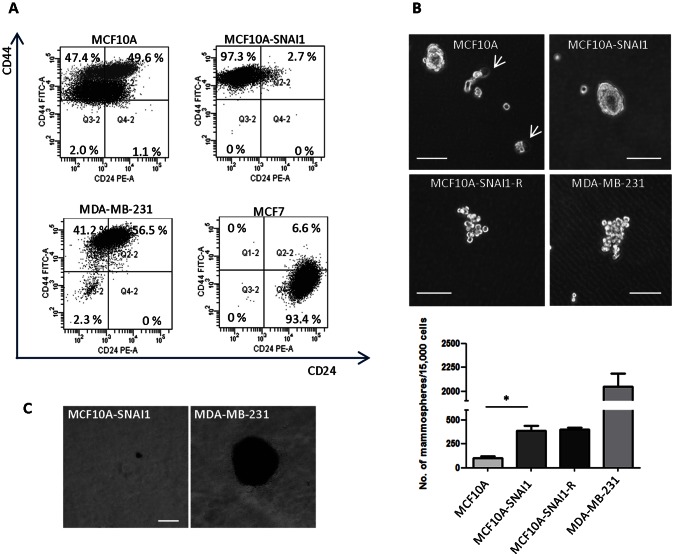
EMT generates CSC-like but not tumorigenic cells.(A) Cell population for surface marker CD44+/CD24− which is associated with breast cancer stem/progenitor cell features was increased in MCF10A-SNAI1 cells. MDA-MB-231 cells and MCF7 cells were used as positive controls for CD44+ and CD24−, respectively. (B) MCF10A-SNAI1 cells showed increased mammosphere formation, while MCF10A cells underwent apoptotic death as shown by arrows. Subpopulation of MCF10A-SNAI1 cells (MCF10A-SNAI1-R) which survived the 5 nM doxorubicin-induced cellular toxicity showed no increased mammosphere forming ability. MDA-MB-231 cells were used as a positive control. Only mammospheres larger than 60 µm were counted. Bar = 100 µm. *P<0.05. (C) In vitro soft agar colony formation assay revealed that MCF10A-SNAI1 cells are non-transformed cells. MDA-MB-231 cells were used as a positive control. Bar = 100 µm.